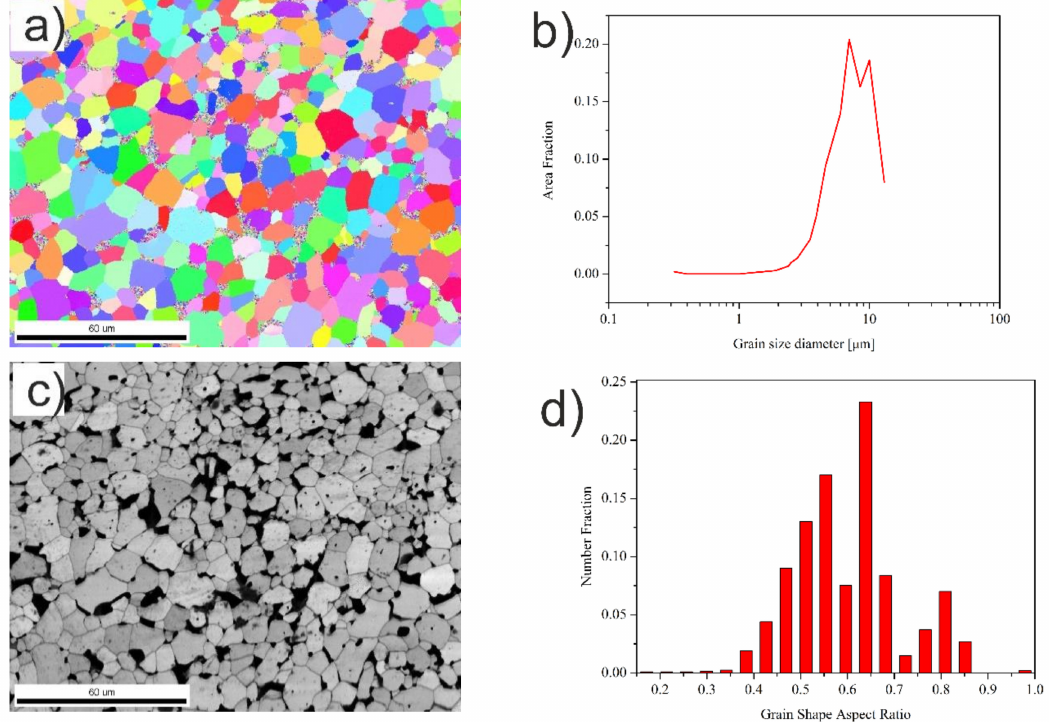
Figure 4. ( a ) EBSD micrograph; ( b ) grain size distribution; ( c ) SEM micrograph; ( d ) grain shape aspect ratio of the Ti + 20 wt %TiMoC/C